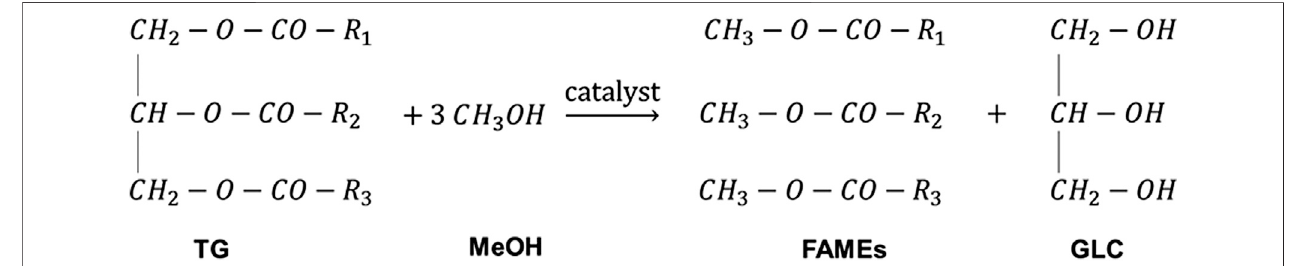
FIGURE 1 | Transesteri fi cation reaction for biodiesel production. R 1 , R 2 , and R 3 are long-chain hydrocarbon/fatty acids.